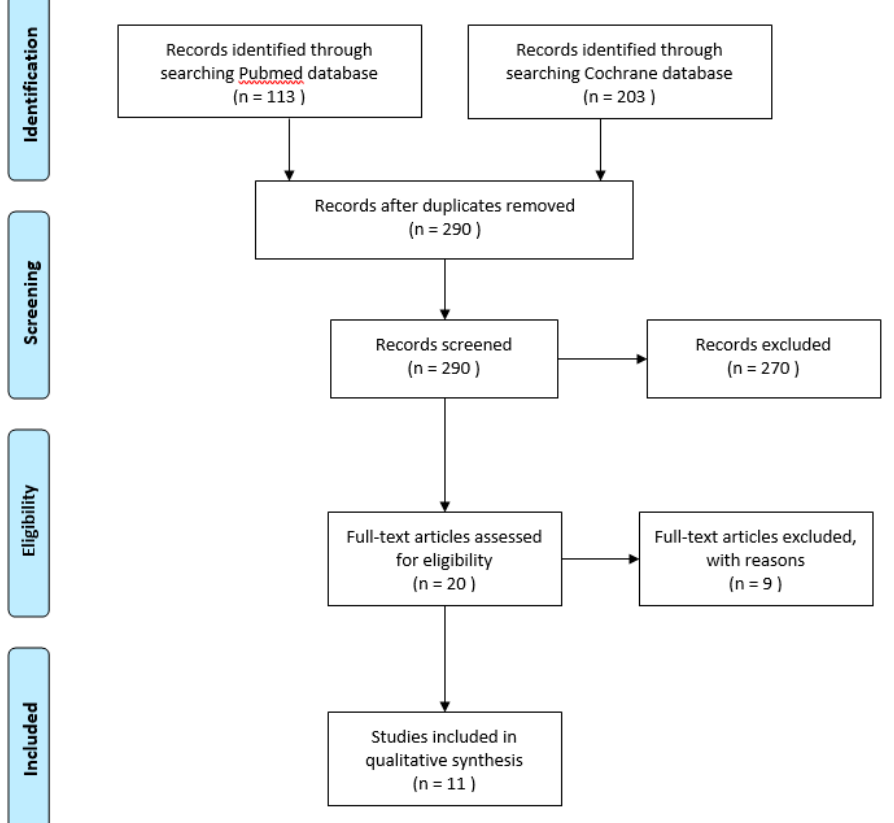
Figure 1. Systematic review flow diagram according to PRISMA guidelines.